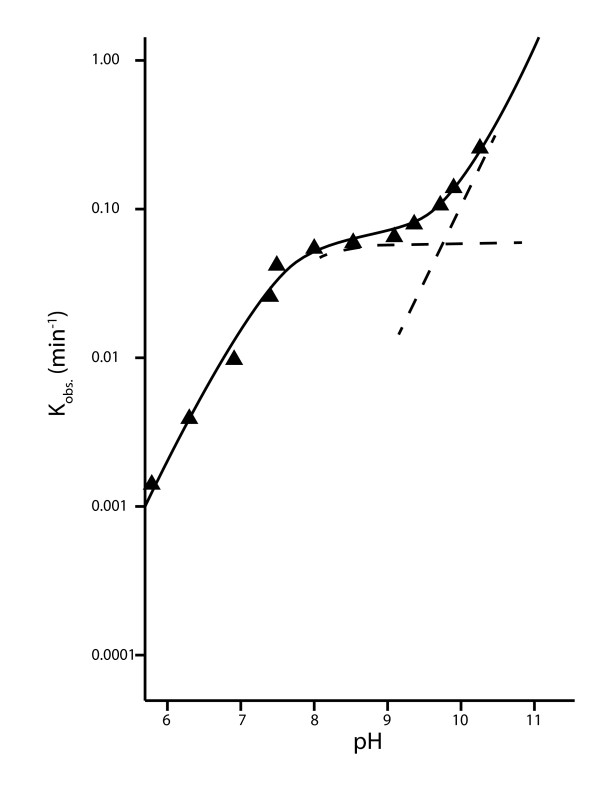
Rate of hydrolysis of aminoacyl-tRNA decreases with pH over the range pH 6-11. Rate of hydrolysis of leucyl-tRNA at 37°C and ionic strength 0.30 (the break in the curve between pH 8-10 represents the shift from rate-determining hydroxide attack on the ammonium acid ester cation to rate-determining attack on the free amino acid ester). Figure adapted with permission from [22] Wolfenden ©1963 American Chemical Society.